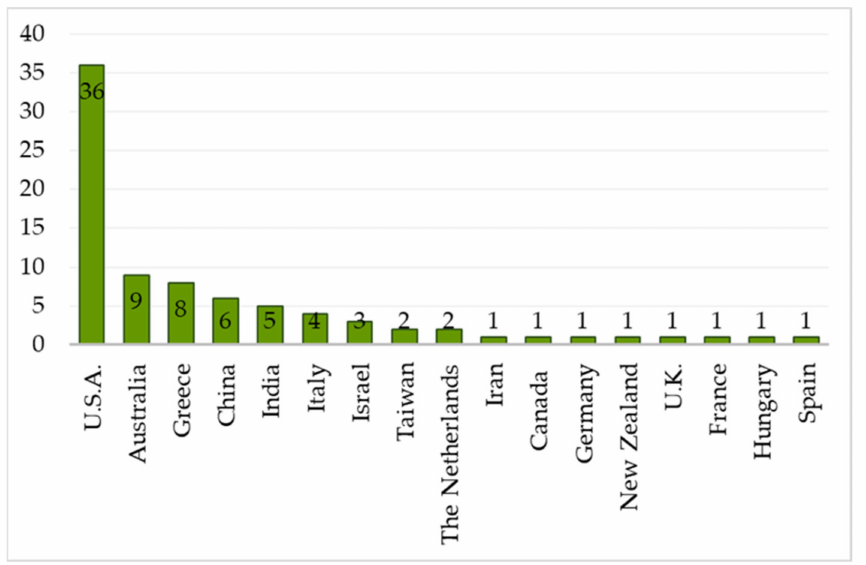
Figure 3. Distribution of papers by